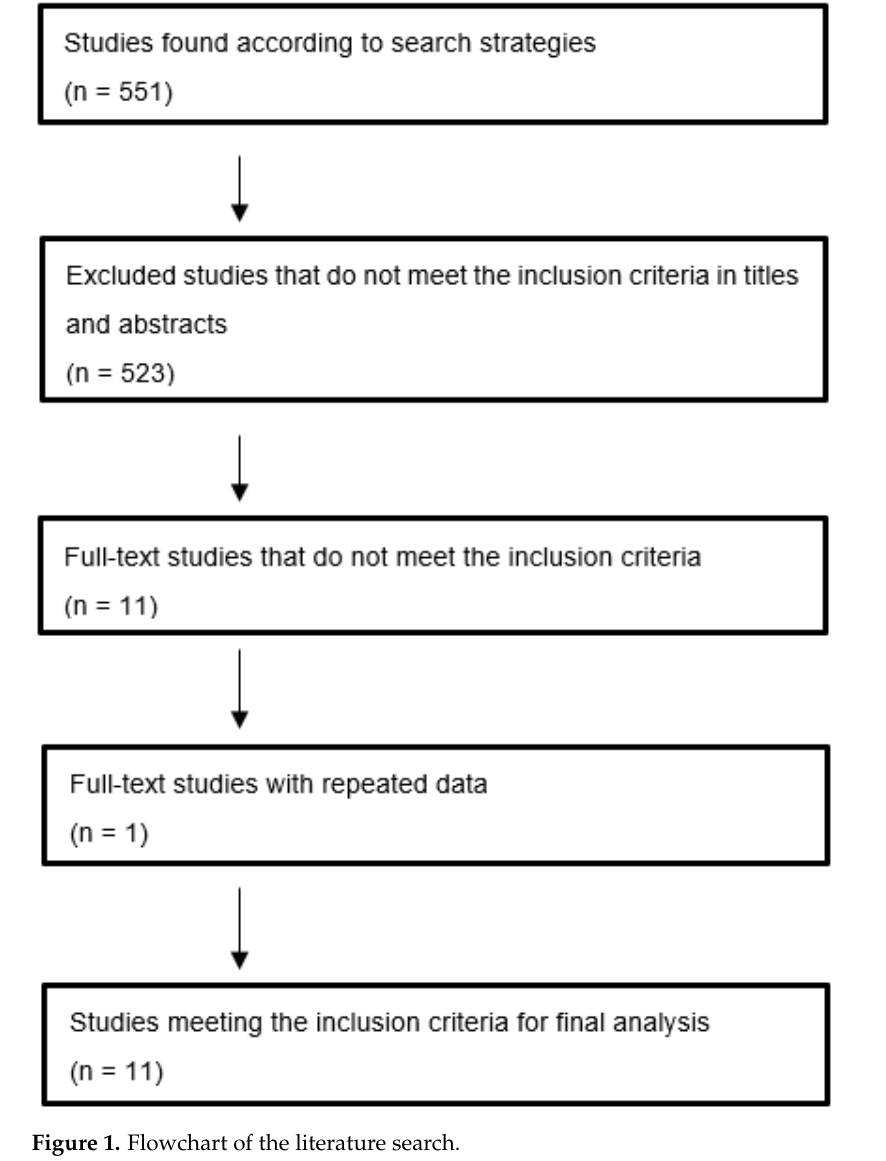
Figure 1. Flowchart of the literature search. Table 1. Studies of